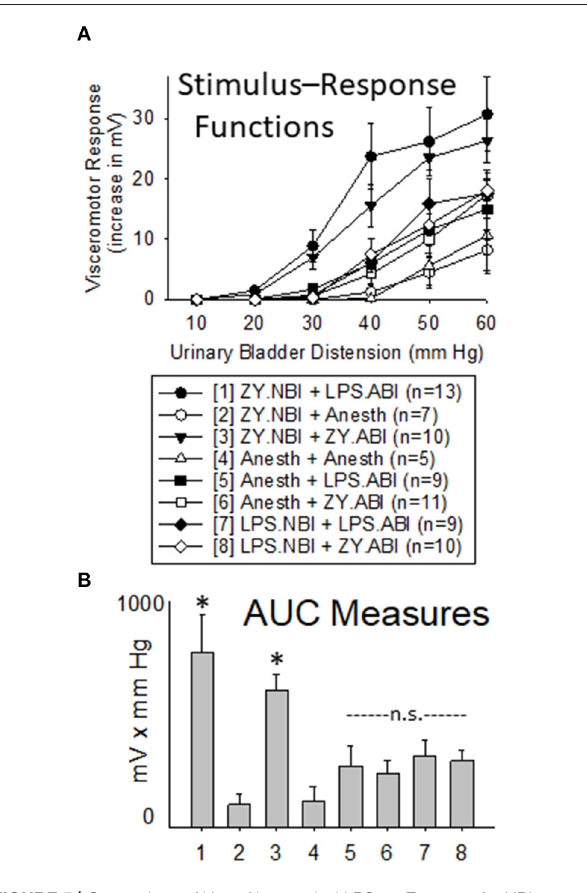
FIGURE 5 | Comparison of Use of Intravesical LPS vs. Zymosan for NBI on VMRs to UBD in Adult Rats. Presentation of data is similar to that in Figures 2 , 3 (group stimulus-response functions in (A) ; Area-Under-the-Curve, AUC, measures in (B) ). “ZY.NBI” and “LPS.NBI” indicate animals in those groups experienced NBI induced by intravesical treatments with zymosan and LPS respectively. Similarly, “ZY.ABI” and “LPS.ABI” similarly indicate adult intravesical treatments producing ABI. “Anesth” indicates control treatments at neonatal and adult timepoints. The “ZY.NBI + LPS.ABI” (Group 1) and “ZY.NBI + ZY.ABI” (Group 3) data were statistically more robust than responses from each of the other groups, but not from each other (Repeated Measures ANOVA; * indicates p < 0.05 for comparison with all other groups). Notably, the robustness of visceromotor responses of the “Anesth + ZY.ABI”, “Anesth + LPS.ABI”, “LPS.NBI + ZY.ABI” and “LPS.NBI + LPS.ABI” (Groups 5–8) did not statistically differ from each other and are indicated as “n.s” for